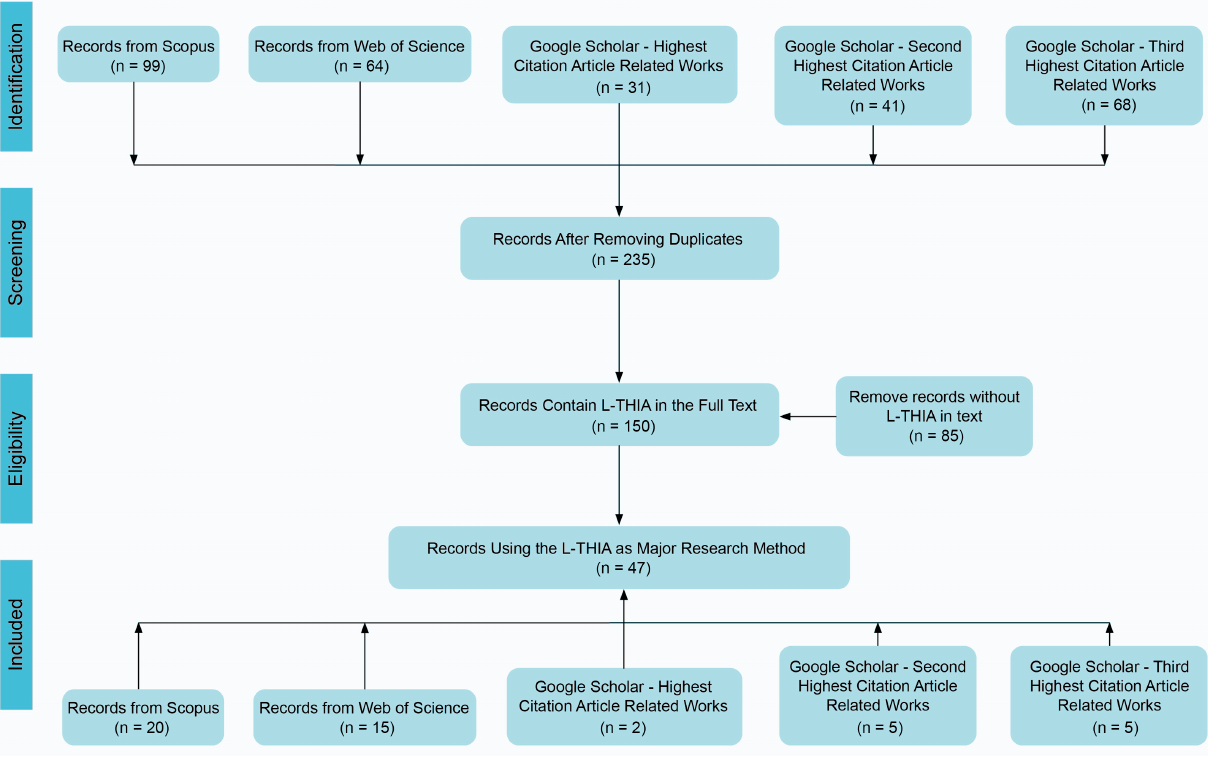
Figure 2. Process for reviewing published applications of the L-THIA and L-THIA-LID models.